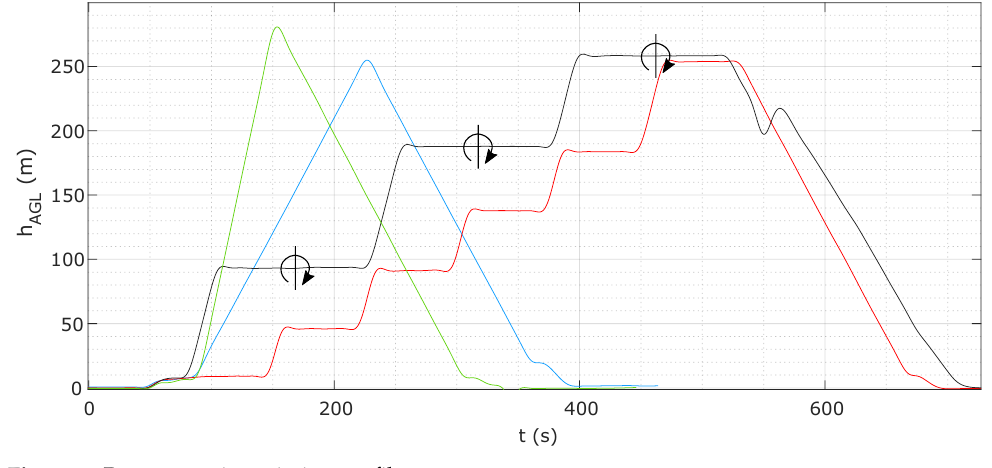
Figure 8. Representative mission profiles. Table 6. Overview of the investigated vertical